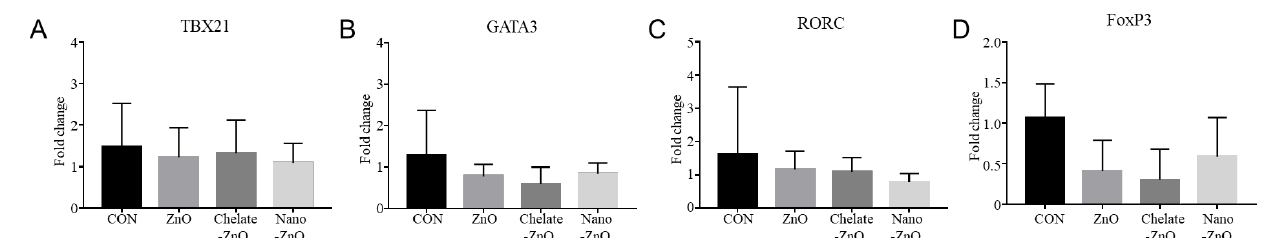
Figure 6. Gene expression of T cell subsets in the colons of weaned pigs fed alternative forms of zinc. T cell subset changes in the colons of piglets exposed to different forms of zinc oxide over two weeks were examined by determining T cell transcription factor expression using qRT-PCR. mRNA expression levels of TBX21 ( A ), GATA3 ( B ), RORC ( C ), and FoxP3 ( D ) in each experimental group were calculated based on that of the negative control group (CON). All fold change values were normalized by GAPDH. Data are represented as mean ± SD. Values were statistically analyzed by one-way ANOVA with Tukey’s multiple comparison test.